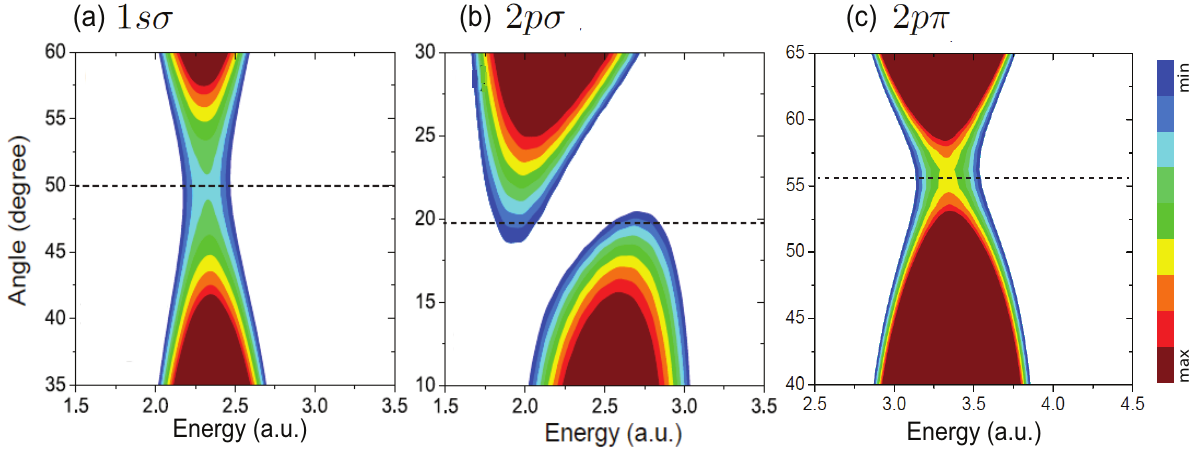
Figure 4. Angle θ resolved MAPES in ( a ) the 1 sσ , ( b ) the 2 pσ , and ( c ) the 2 pπ electronic states of the x oriented molecular ion HHe 2+ at R = 2 a.u. with intensity I = 5 × 10 14 W/cm 2 circularly polarized attosecond XUV laser pulses. The corresponding 0 pulse wavelengths and durations are respectively (a) λ = 10 nm and T = 265 as, (b) λ = 12 nm and T = 318 as, and (c) λ = 12 . 5 nm and T = 333 . 6 as. Dashed lines denote the critical angles ϑ . Signal intensities of the ionization spectra are on a logarithmic scale in arbitrary c units. Adapted from